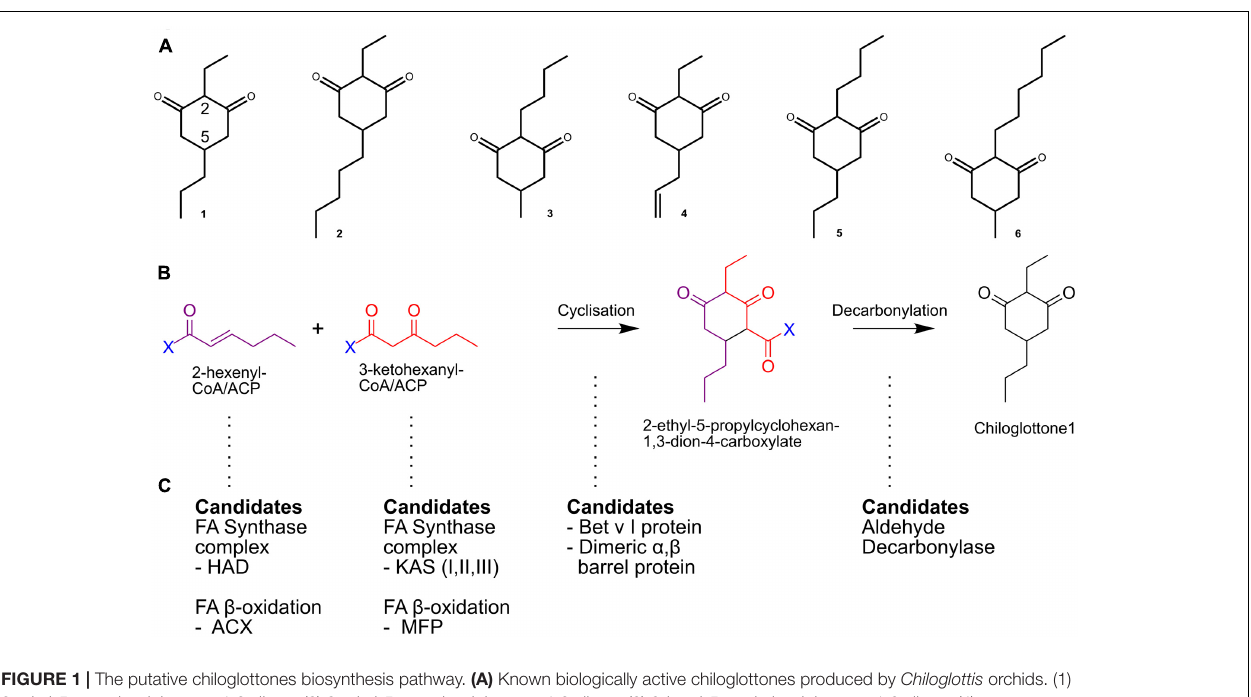
FIGURE 1 | The putative chiloglottones biosynthesis pathway. (A) Known biologically active chiloglottones produced by Chiloglottis orchids. (1) 2-ethyl-5-propylcyclohexane-1,3-dione; (2) 2-ethyl-5-pentylcyclohexane-1,3-dione; (3) 2-butyl-5-methylcyclohexane-1,3-dione; (4) 5-allyl-2-ethylcyclohexane-1,3-dione; (5) 2-butyl-5-propylcyclohexane-1,3-dione; (6) 2-hexyl-5-methylcyclohexane-1,3-dione. (B) Presumed biosynthetic steps for chiloglottone 1 formation. (C) Potential metabolic routes and enzymes involved in activated precursor origins, cyclization, and decarbonylation reactions.